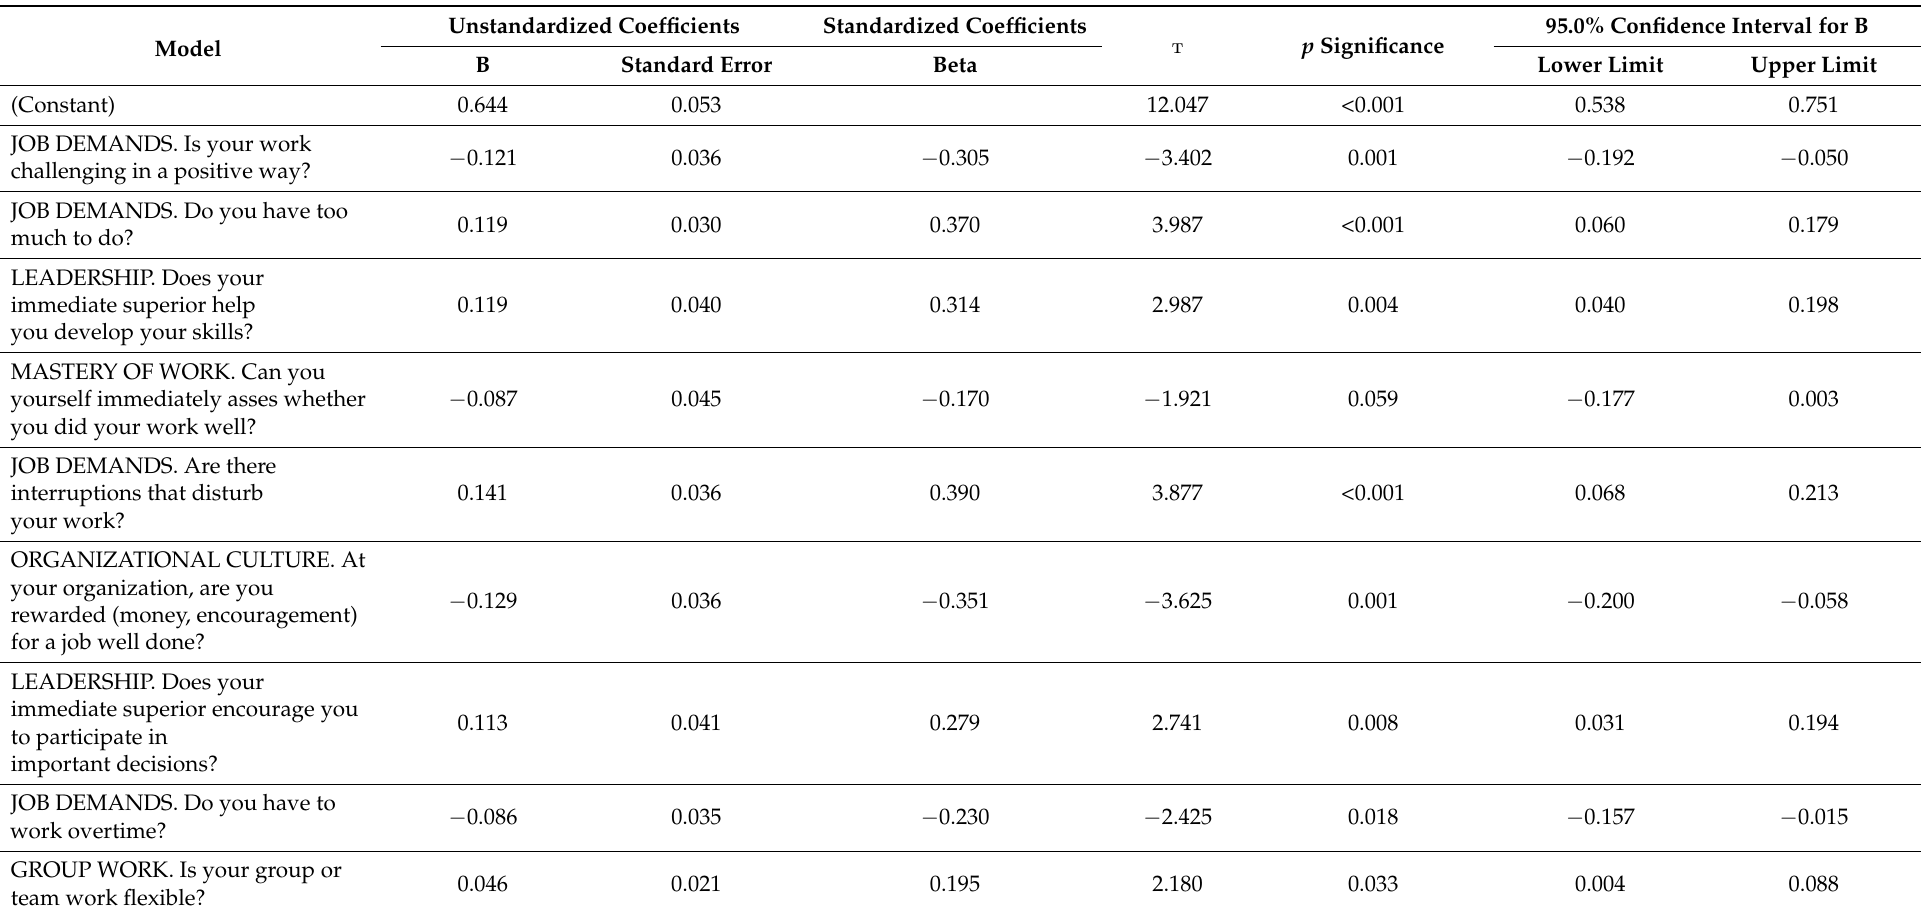
Table 7. Contribution of the assessments of psychosocial factors (coefficients of the regression equation) to the variability of loggers’ general functional